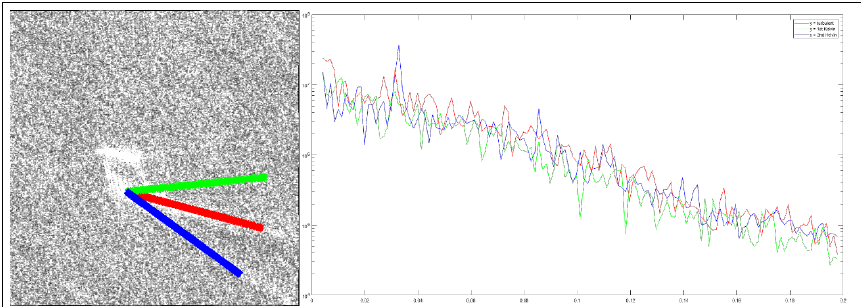
Figure 20. Linear sampling on the wake signal presented in Figure 1. The observed peak in the blue curve corresponds to the wavelength of the periodical wake component (COSMO-SkyMed Product— c (cid:13) ASI 2016 processed under license from ASI—Agenzia Spaziale Italiana, all rights reserved, distributed by